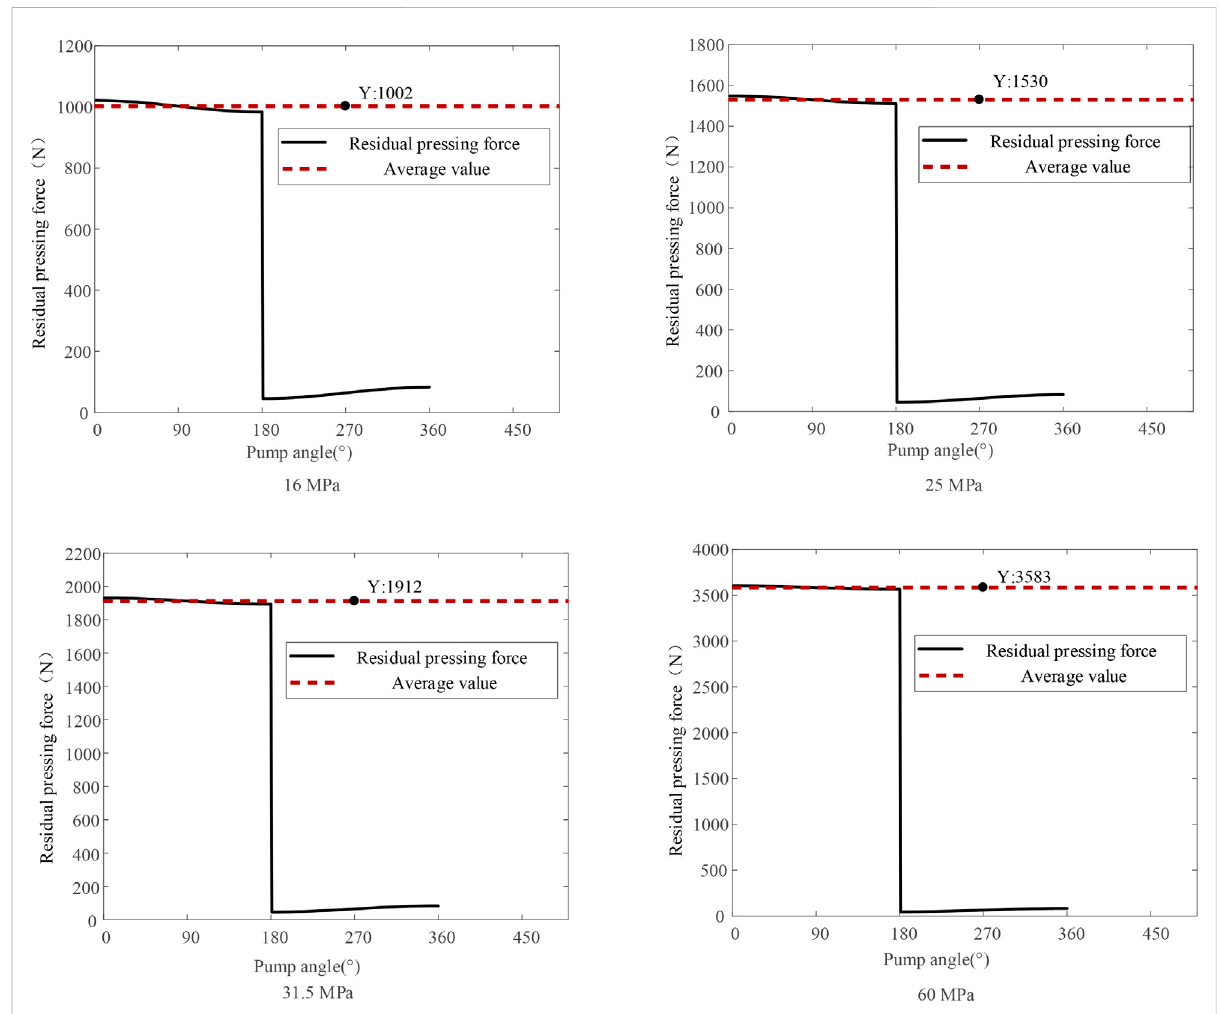
FIGURE 10 A11VLO190 swashplate axial piston pump residual pressing force size and variation pattern.